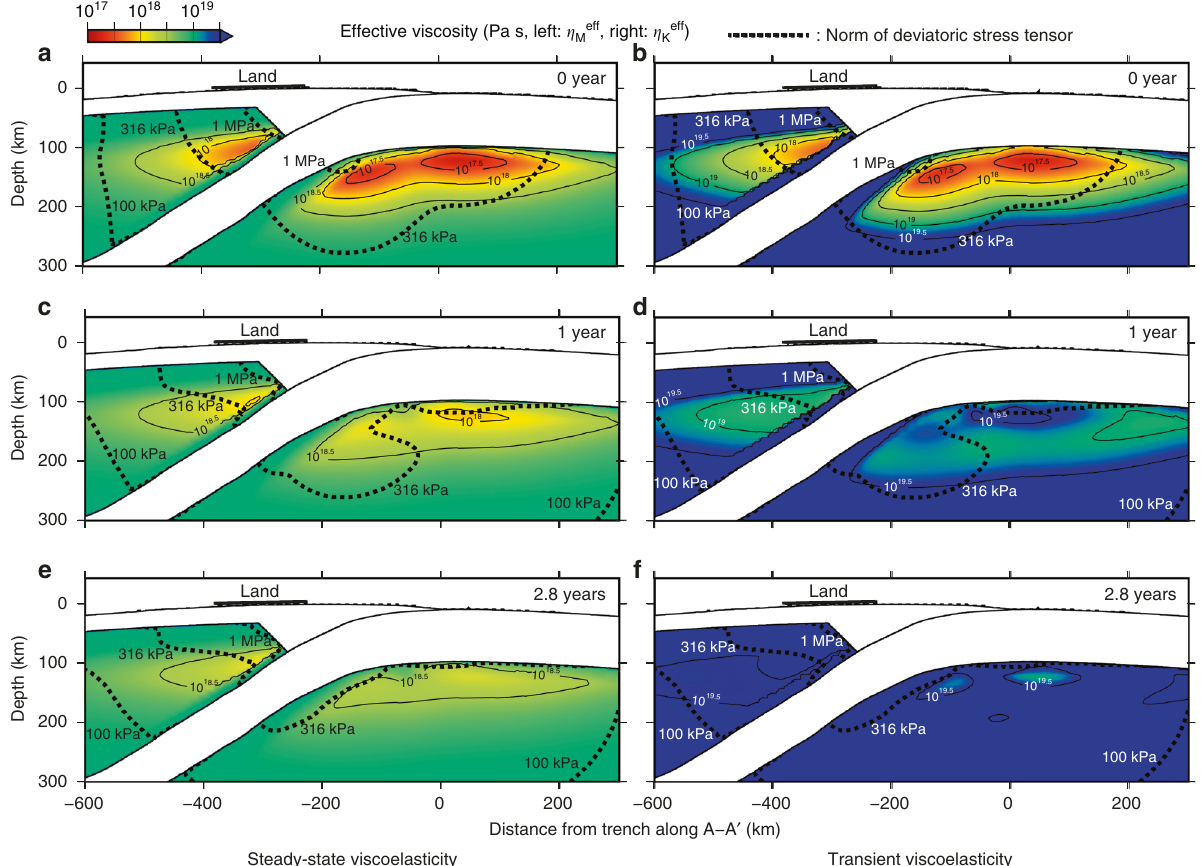
Fig. 5 Distributions of effective viscosity. The panels show those in the steady-state and transient creep a , b shortly (at 0 year), c , d at 1 year and e , f at 2.8 years after the earthquake. See Methods for the de fi nition of effective viscosity. The dashed line indicates summation of the background stress and the coseismic stress (norm of deviatoric stress tensor). Due to the power-law the stress relaxation is accompanied by material hardening, with a temporal increase in effective viscosity. As the material hardens, deformation is progressively accommodated by steady-state creep